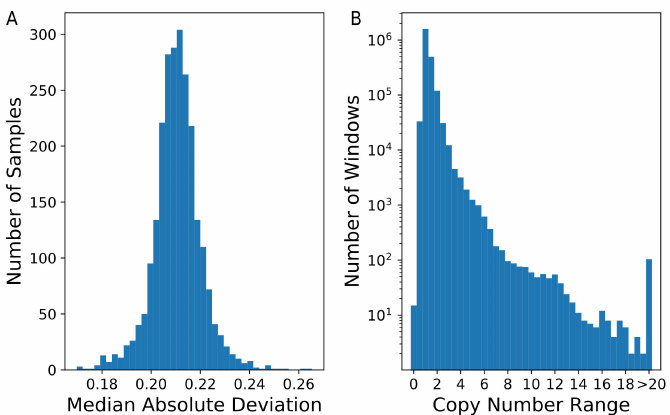
Figure 2. Distribution of inferred paralog-specific copy-numbers. Copy number was estimated for 2457 individuals using nonoverlapping windows that each contained 1000 k-mers. ( A ) A histogram of the median absolute deviation (MAD) calculated for all individuals is shown. ( B ) The copy-number range for each window across all samples was determined. A histogram of these ranges is shown. Note that the Y-axis is plotted on a logarithmic scale.